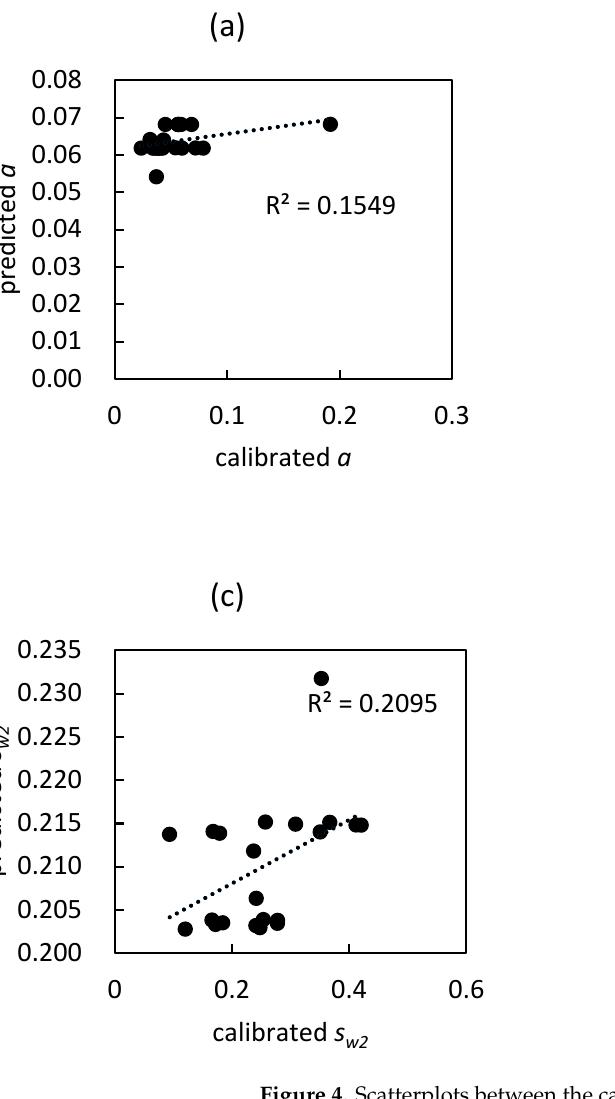
Figure 4. Scatterplots between the calibrated SMAR parameters and the predicted SMAR parameters from the random forest model and independent variables. The parameters are ( a ) a , ( b ) b , ( c ) s w2 and ( d ) s c1 .